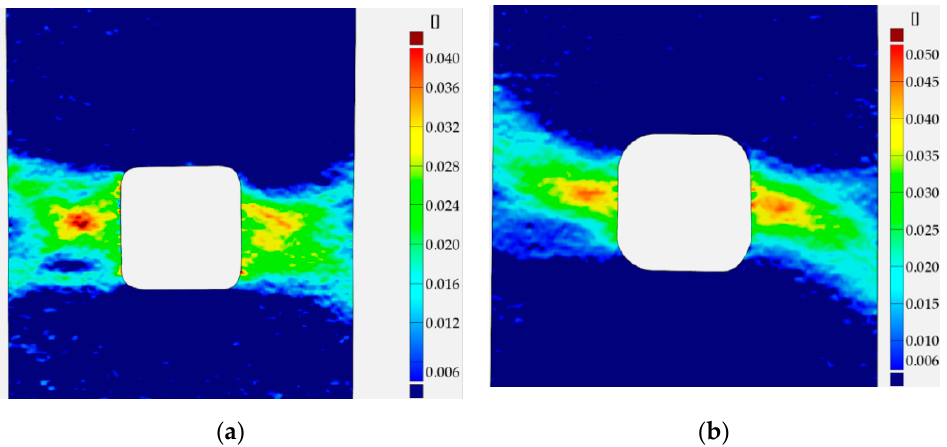
Figure 27. Distribution of strain field (DIC) in samples with square holes made of S355MC steel: ( a ) Sample 9 with corner fillet radius R2; and ( b ) Sample 10 with corner fillet radius R4.